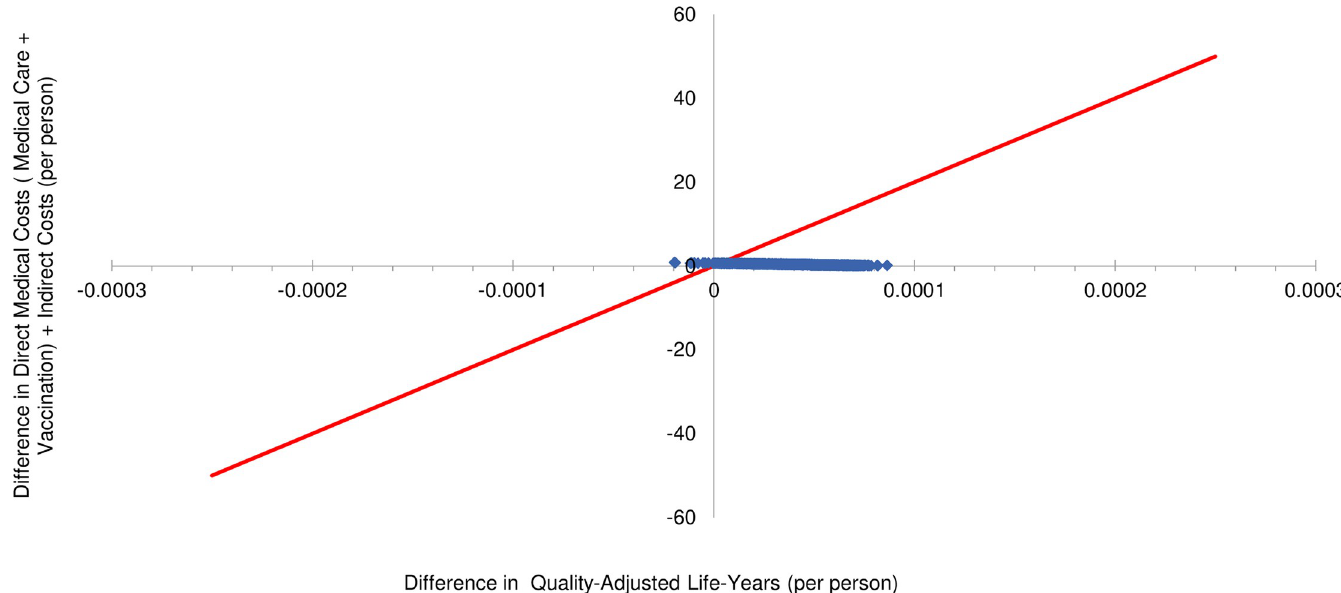
Fig 5. Graphical illustration of PSA for the public health care sector mixed model. Costs are indicated in 2015 South African rand.